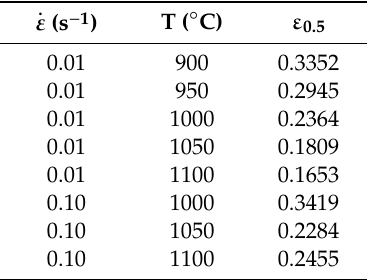
Table 4. ε 0.5 values under di ff erent test